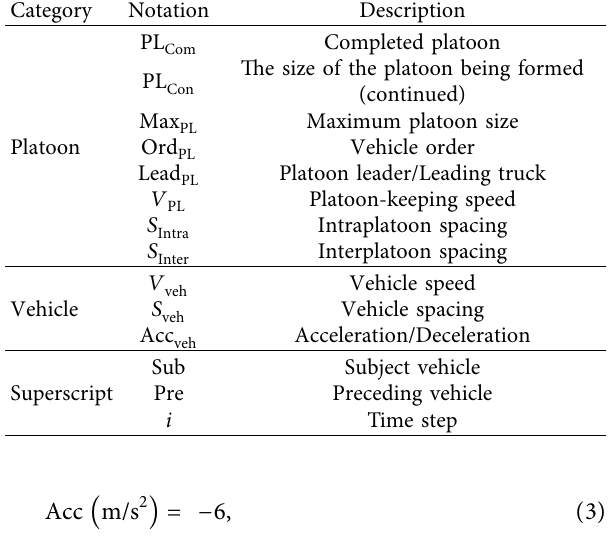
Table 1: Definition of terms used in platoon formation algorithms. Category